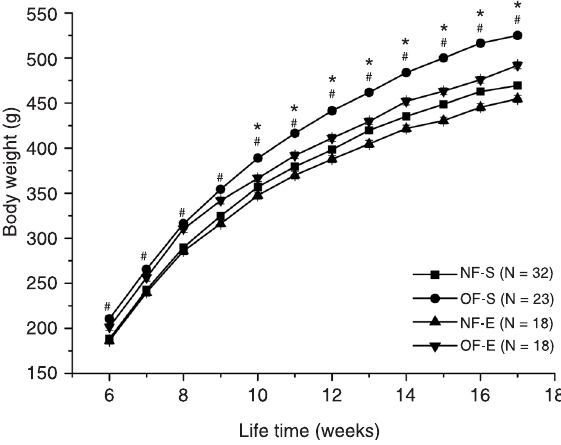
Figure 3. Effect of aerobic exercise on the body weight gain curve. Data are reported as means ± SEM. NF-S = normally fed sedentary; OF-S = overfed sedentary; NF-E = normally fed ex- ercised; OF-E = overfed exercised. *P < 0.05 OF-S vs OF-E; # P < 0.05, NF-S vs OF-S (two-way ANOVA for repeated measures followed by the Tukey post hoc test).